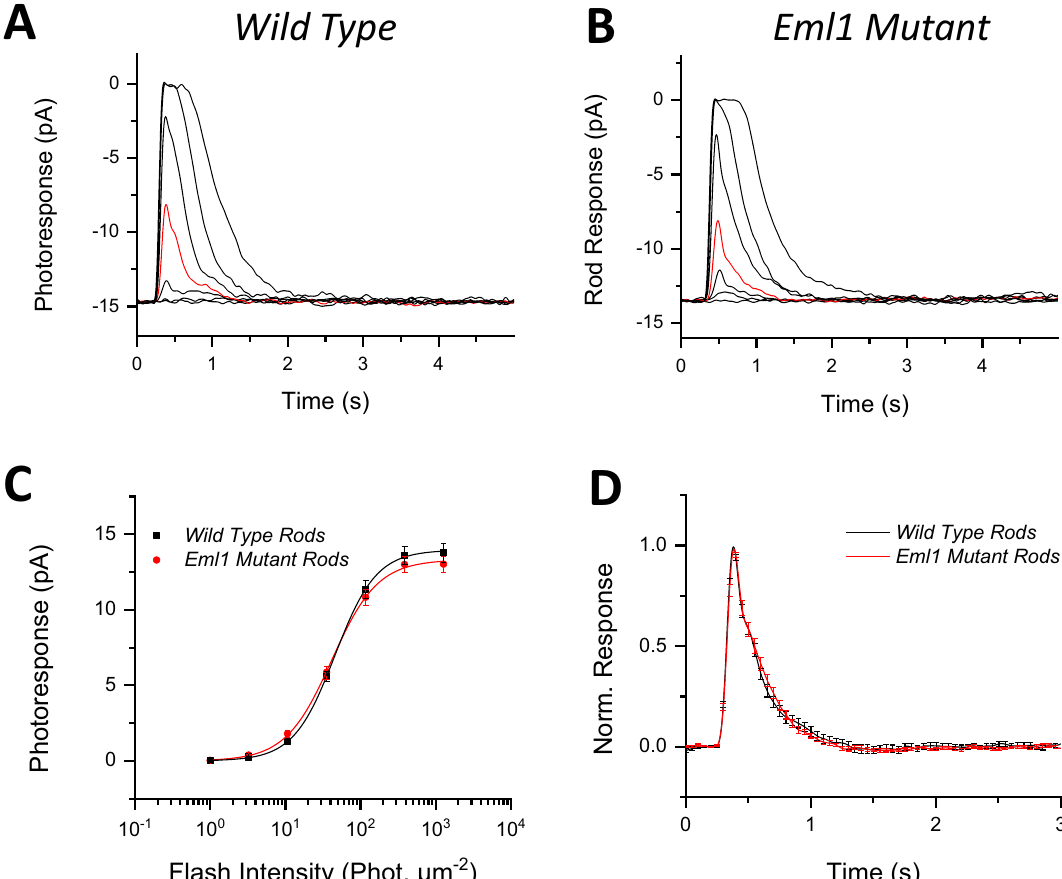
Figure 4. Effect of Eml1 mutation on single rod responses. Representative responses of individual rods to a flash family (photons μm −2 ): 1, 3, 10.7, 35, 117, 386 and 1271 in wild type ( A ) and Eml1 mutant ( B ) animals. For comparison, the responses to a flash of 35 photons μm −2 are highlighted in red. ( C ) Average flash family responses from wild type (black) and Eml1 mutant rods ( red ) groups plotted together as a function of flash intensity. The lines represent Naka-Rushton function fits to the data. ( D ) Dim flash responses of wild type ( black ) and Eml1 mutant ( red ) rods for comparison of response kinetics. Error bars show S.E.M for all